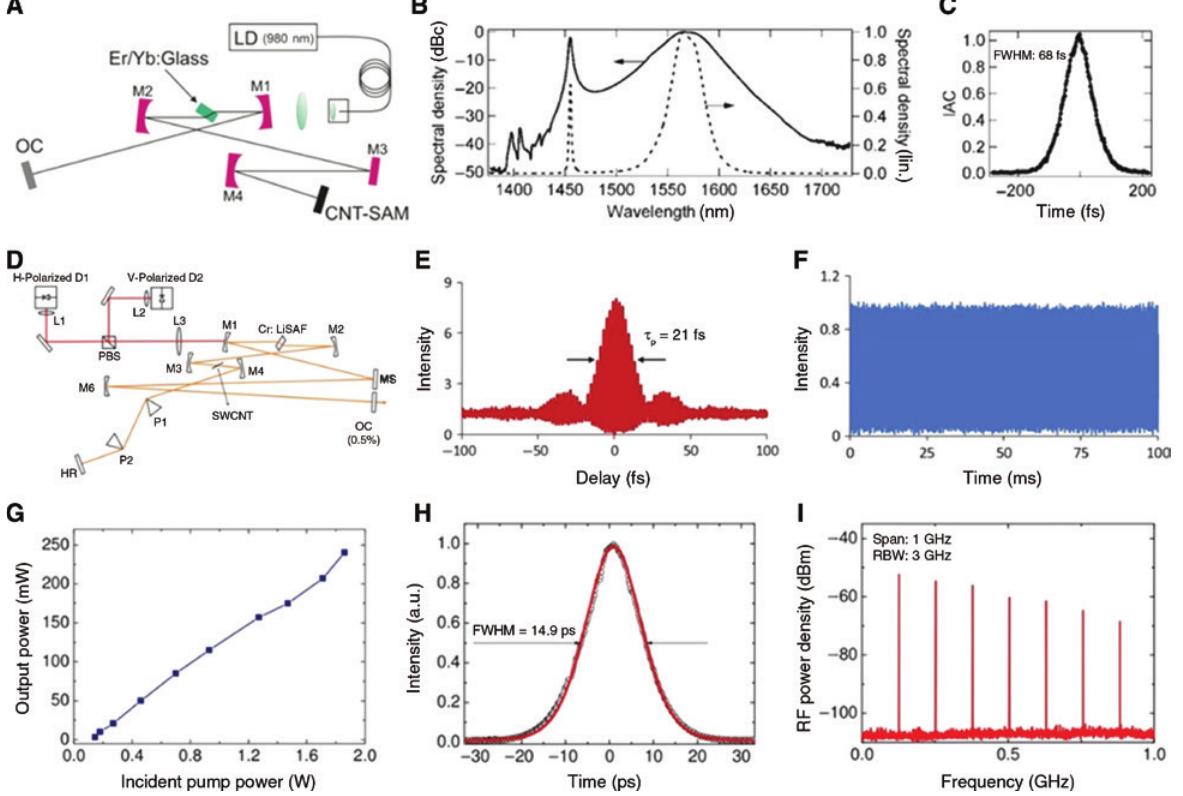
Figure 7: Performance of CNTs mode-locked lasers. (A) Experimental setup, (B) optical spectrum, and (C) autocorrelation trace of the CNTs mode-locked Er/Yb:glass laser. Reproduced with permission [86]. Copyright 2005, Optical Society of America. (D) Experimental setup, (E) autocorrelation trace, and (F) mode-locked pulse trains of the SWCNTs mode-locked Cr: LiSAF laser. Reproduced with permission [114]. Copyright 2019, Optical Society of America. (G) Average output power vs. incident pump power, (H) autocorrelation trace and (I) wide-span RF spectrum of the SWCNT Mode-locked Tm:KLuW laser. Reproduced with permission [90]. Copyright 2009, Optical Society of